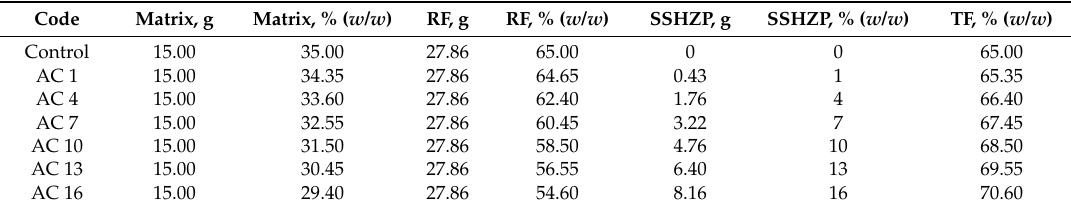
Table 1. Compositions of investigated materials with the masses of components needed to prepare standard